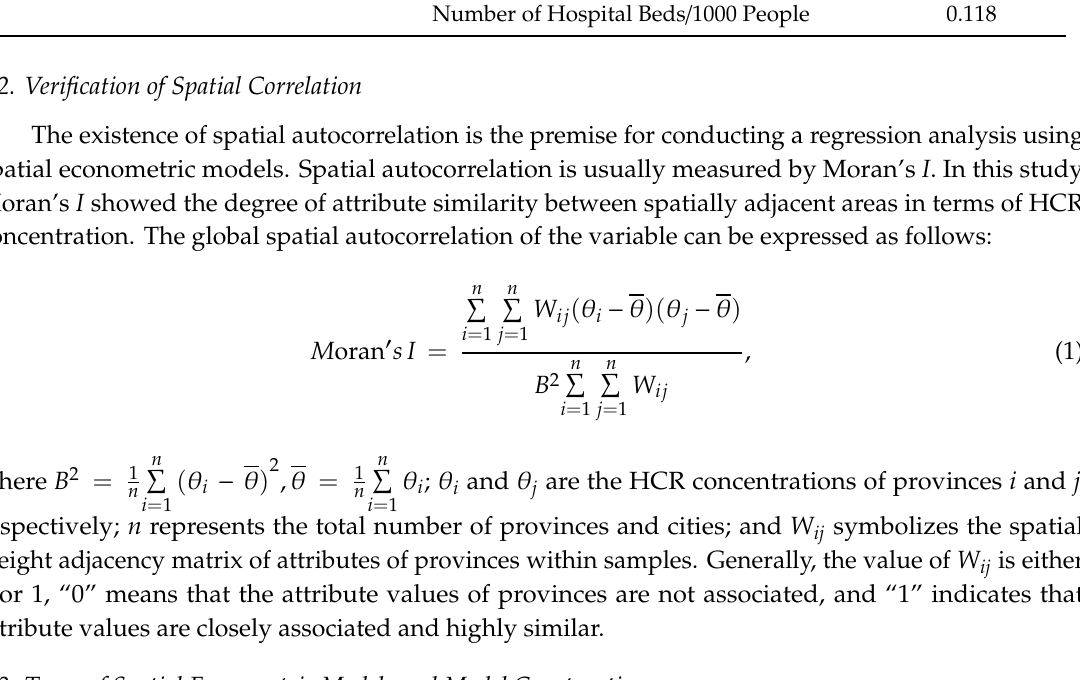
Concentration of Healthcare Resources